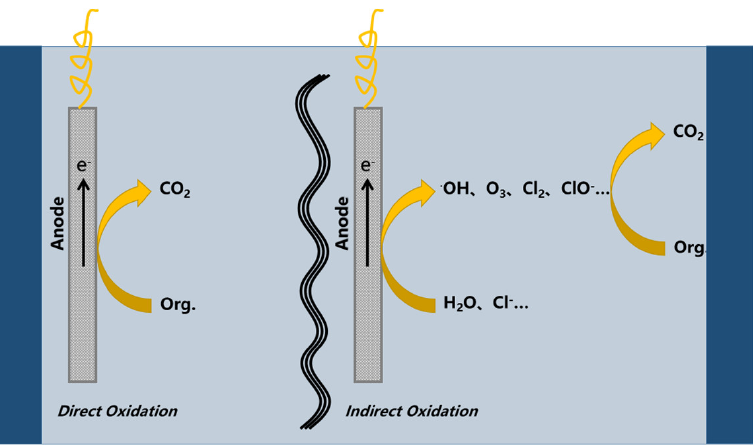
Figure 1. Schematic diagram of the reaction mechanism of an EO reactor.